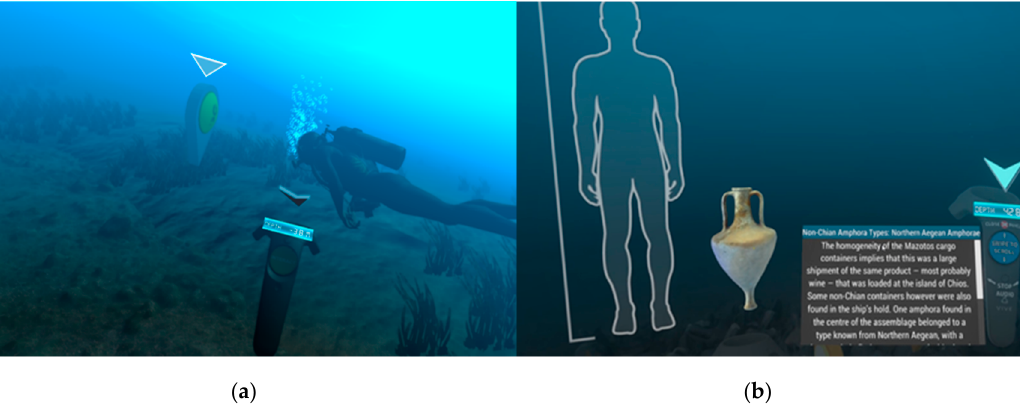
Figure 3. ( a ) Virtual diver for the exploration of the underwater archaeological site; ( b ) Visualization of the multimedia content related to a POI in the virtual